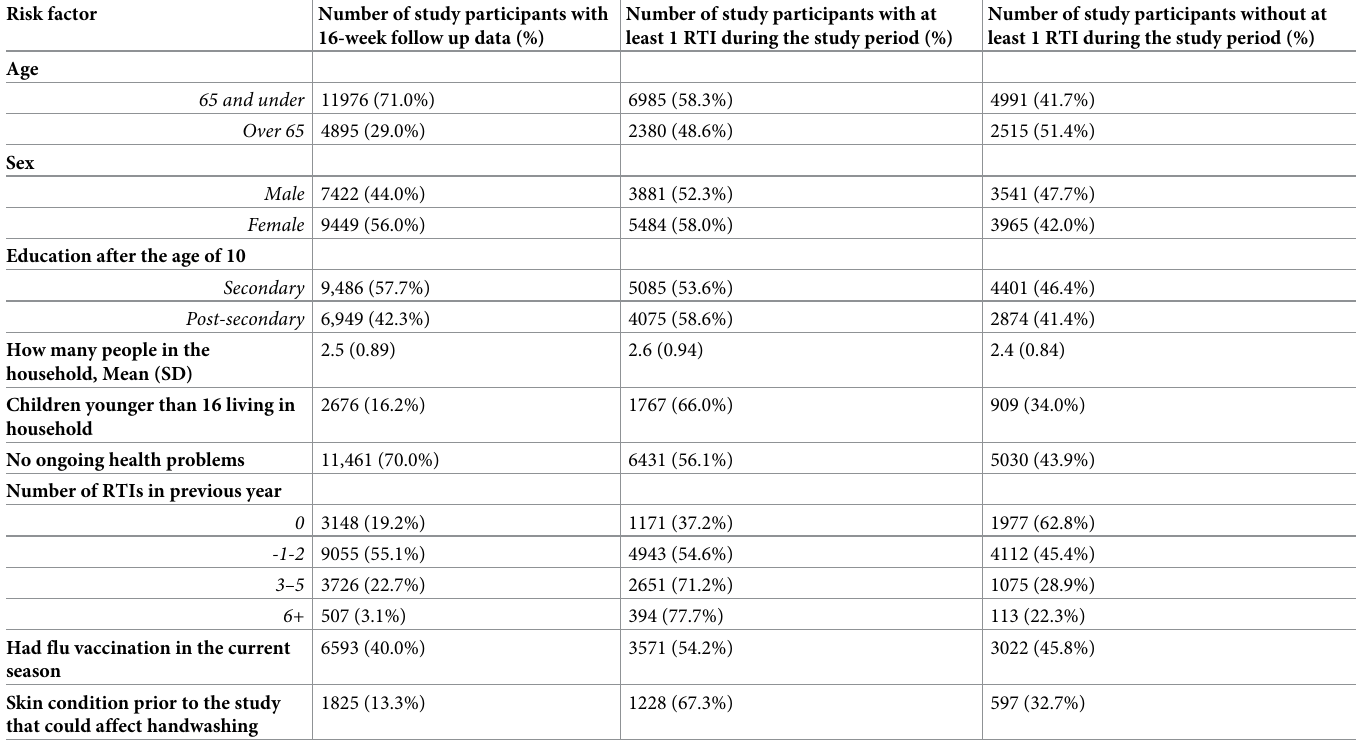
Table 1. Number of PRIMIT study participants for each investigated risk